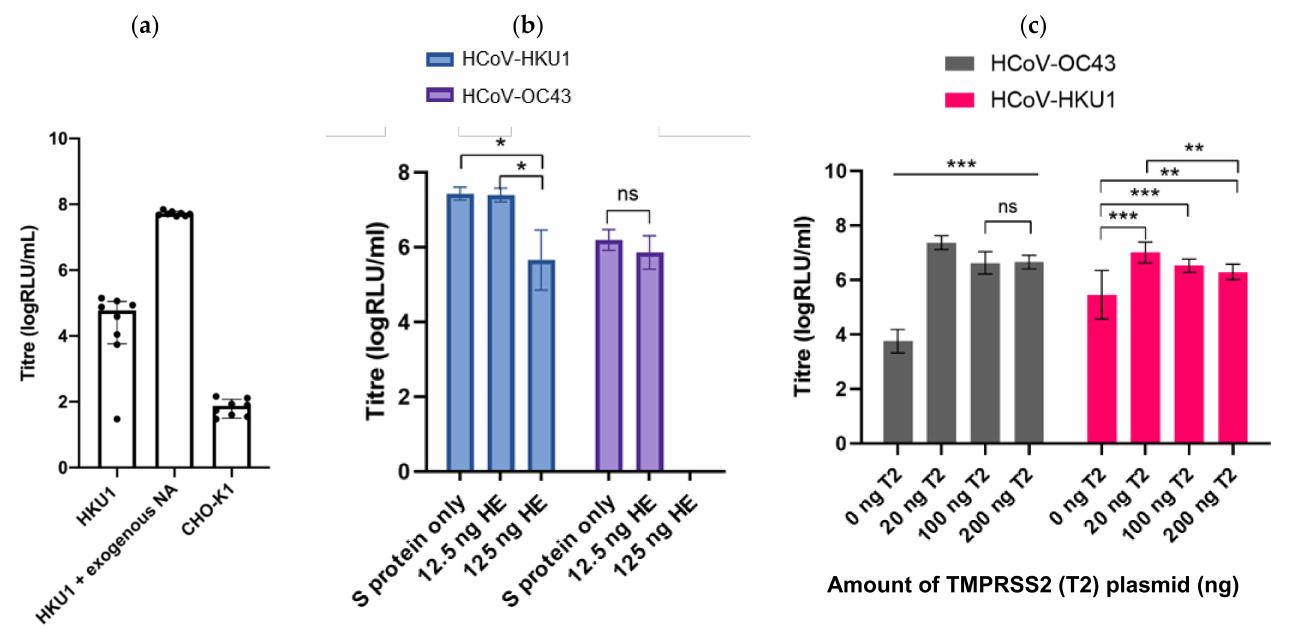
Figure 5. Enhancing titres of HCoV-OC43 and HCoV-HKU1: ( a ) entry of HKU1 PVs into CHO cells was enhanced after incubation with exogenous NA relative to CHO-K1 cell only control; ( b ) HCoV-OC43 or HCoV-HKU1 PVs were generated incorporating their corresponding Haemagglutinin Esterase (HE) protein in addition to the spike protein. Co-transfection of 12.5 ng of HE led to comparable titres to spike-only PVs for both viruses when used with TMPRSS2-transfected HEK293T/17 cells (see below). Transfection of higher inputs of HE led to reduced titres for both viruses. ( c ) Production of HCoV-OC43 and HCoV-HKU1 was enhanced by co-transfection of producer cells with TMPRSS2; this enhanced entry of HCoV-OC43 over 3000-fold compared to un-transfected HEK293T/17 cells. Significant differences in titre shown by asterisks: * represents p ≤ 0.05, ** p ≤ 0.005 and *** p ≤ 0.0005, respectively.